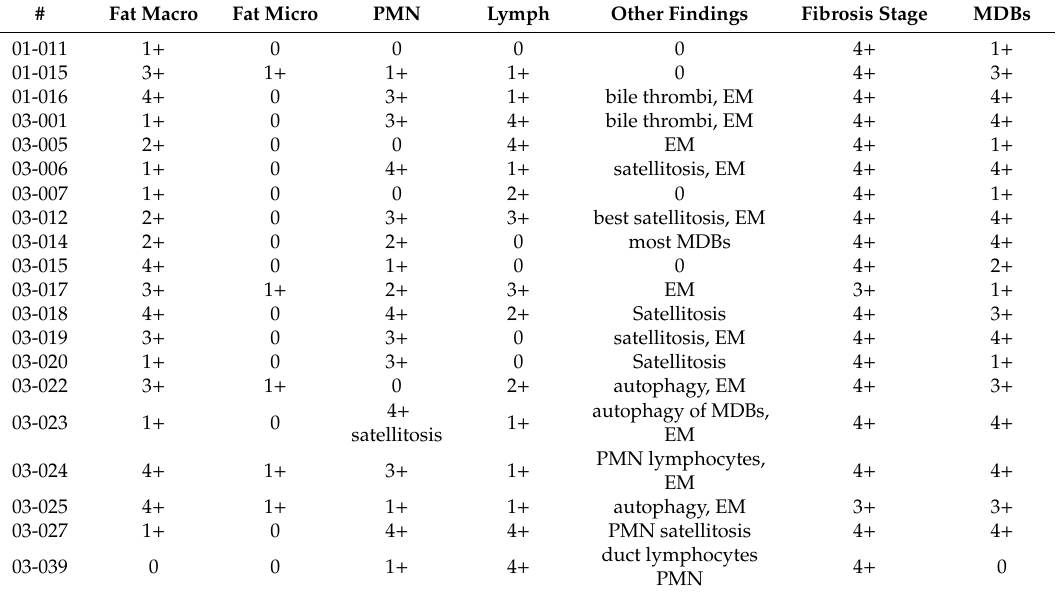
Figure 3. MDBs in balloon cells (CAM5.2). The black arrow points to the balloon cells with MDBs. The green arrow points to the bile duct metaplasia seen in alcoholic hepatitis. The lymphocytes (CD4) are nibbling the hepatocytes at the MHC antigen binding sites (immunologic synapsis) to gradually remove the hepatocytes ( × 640). Table 1. Patients with AH studied for changes in the expression of